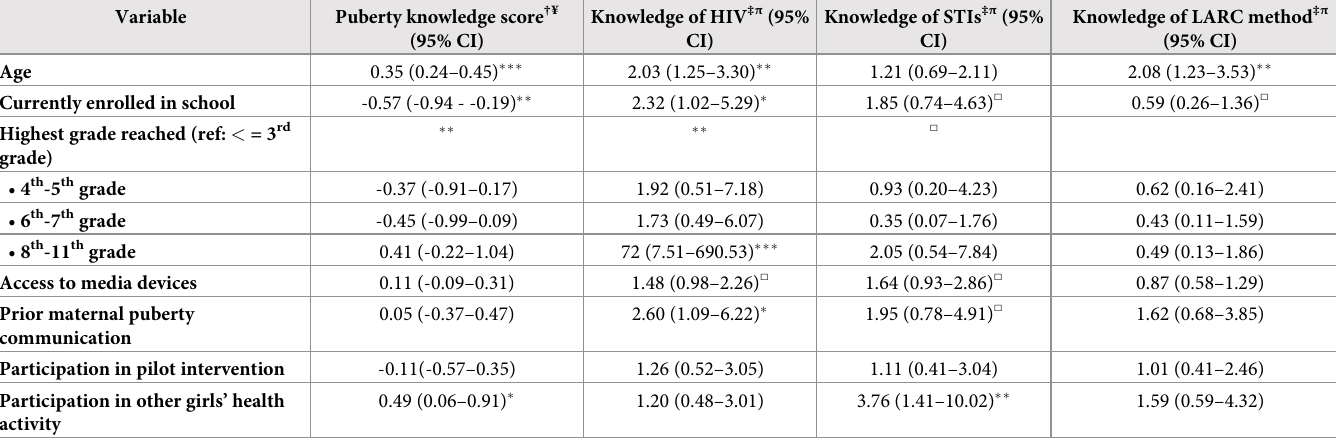
Table 4. Bivariate analysis for knowledge outcomes of interest.